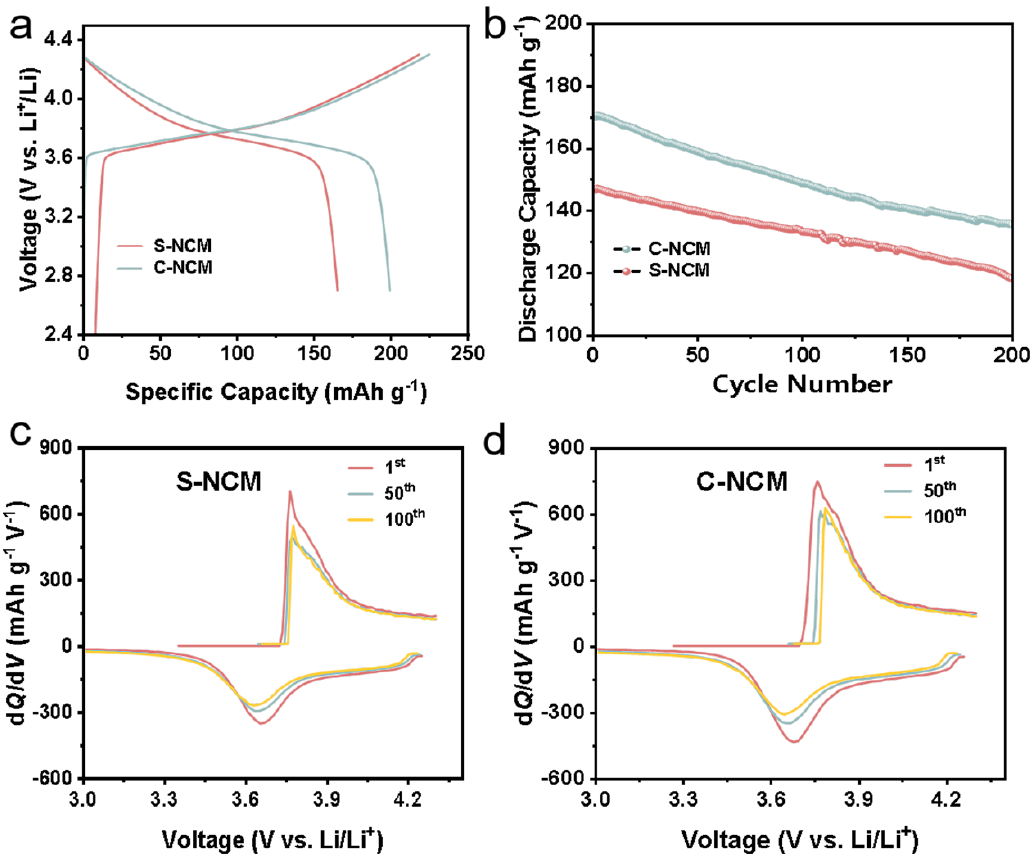
Figure 8. ( a ) Initial charge/discharge curves at 0.1 C, ( b ) cycling performance at 1 C, and differential capacity vs. Voltage (dQ/dV) profiles of ( c ) S–NCM and ( d ) C–NCM for the 1st, 50th and 100th cycles at 1 C.